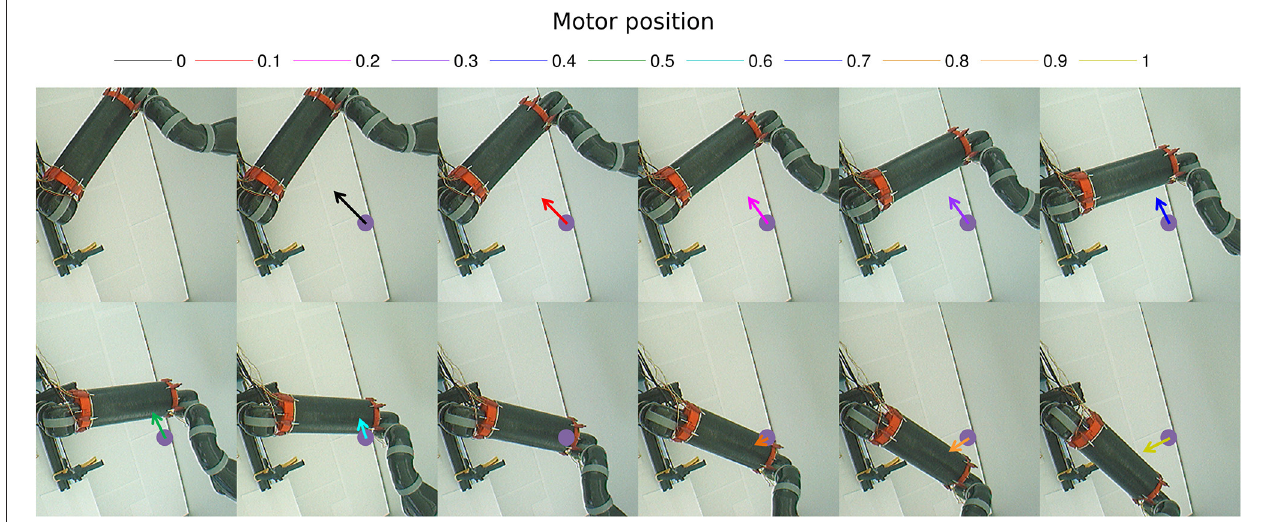
FIGURE 10 | Gain-field visual unit receptive field centered on the target C. Snapshots of the relative visual distance and orientation for the target located in C in Figure 9 computed by the compound GF units from the arm and target centered RF when the arms moves in the interval [0 ◦ − 100 ◦ ]. The arrows length corresponds to the amplitude level of the neurons, i.e., the proximity of the RF, and their orientation corresponds to the orientation. The color code represents the different motor positions. For better visualization, we have increased the length of the arrow by 10